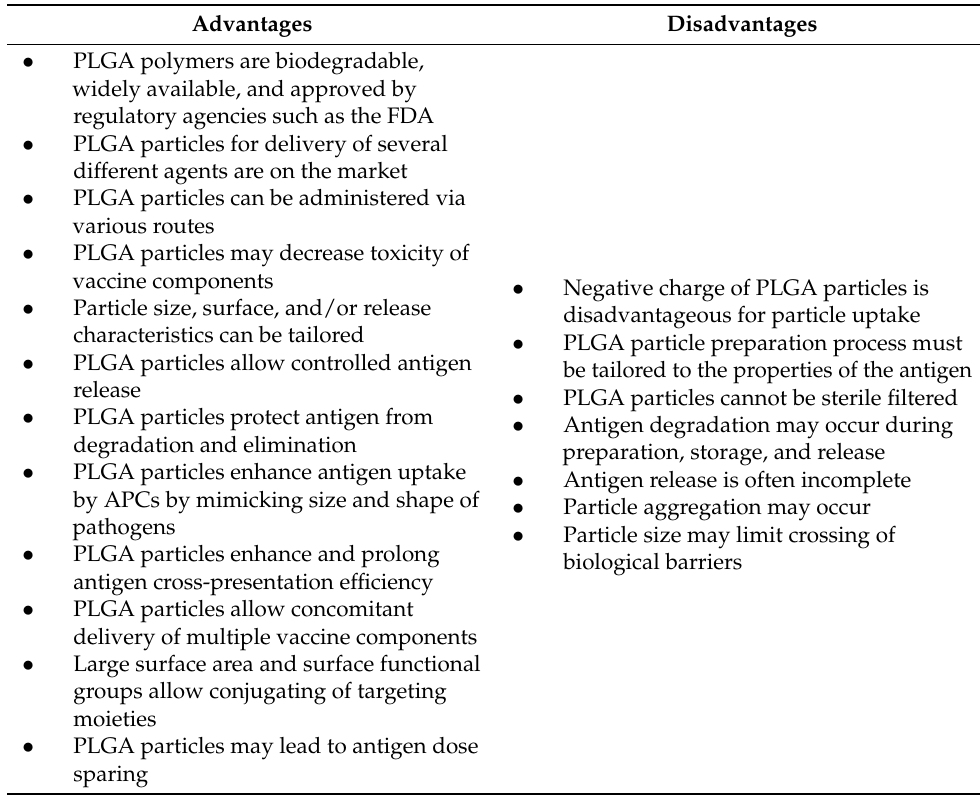
Table 2. Summary of the main advantages and disadvantages of PLGA-based particulate vaccine delivery systems. (Adapted from